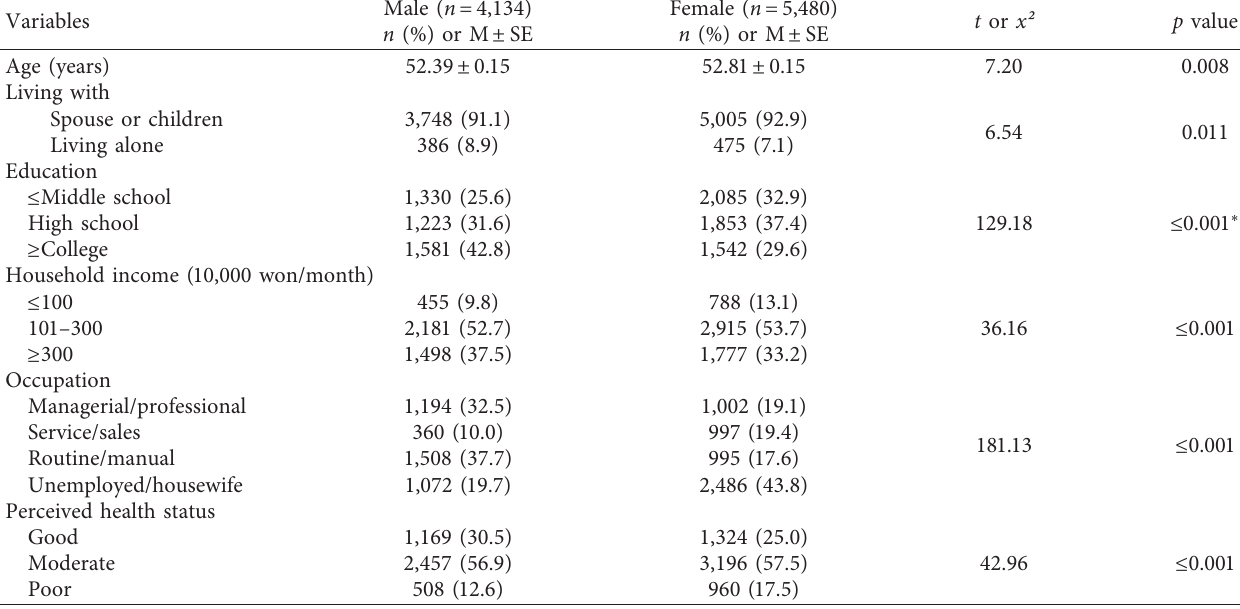
Table 1: Comparison of the participants’ general characteristics according to sex ( n �